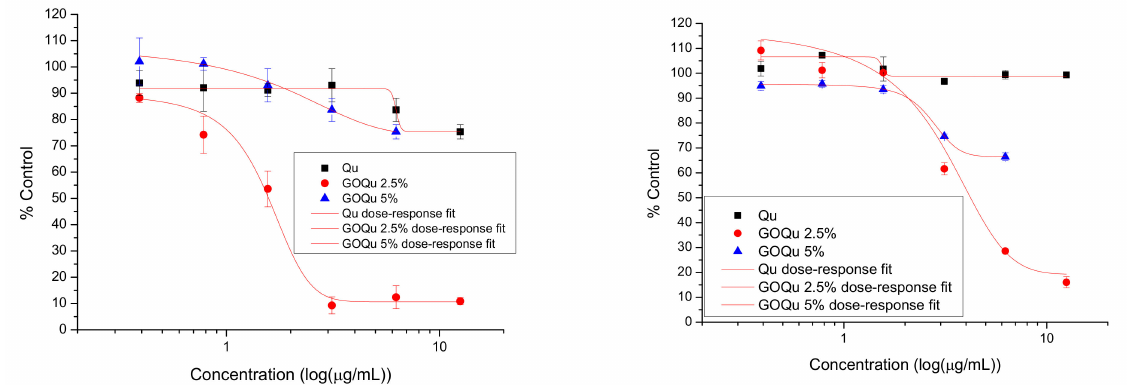
Figure 11. Cytotoxicity of GOQu on L929 ( left ) and BT474 ( right ) cells: proliferation of cells incubated with Qu (black sqare), GOQu 5% ( w / v ) (blue triangle), and GOQu 2.5% ( w / v ) (red dot), in equivalent concentrations, over 48 h. Data are calculated as percentage of untreated control and are shown as mean ± SD and represented as dependent on the drug concentration decimal logarithm. The red curves have been obtained using the dose–response fit in OriginPro 8.6.